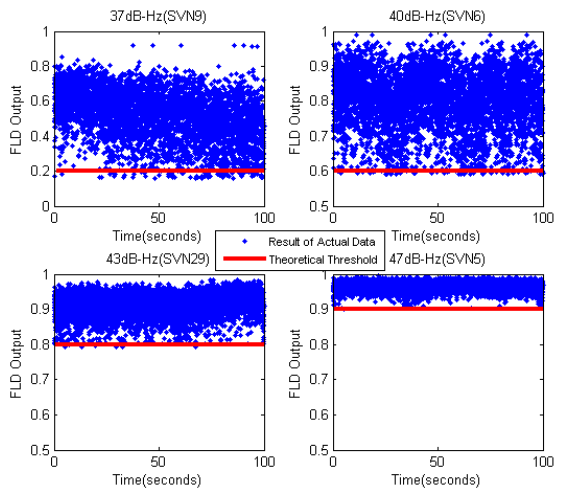
Figure 14. FLD output of actual data with different C / N 0 ( M = 20).